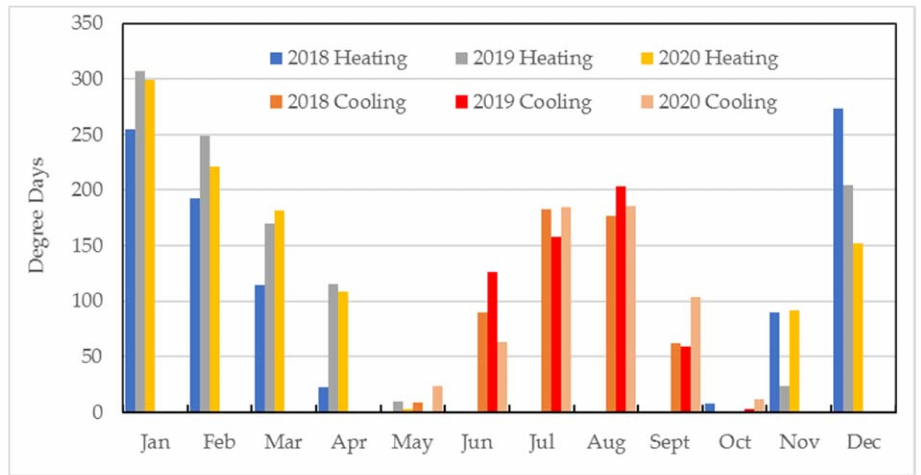
Figure 2. Heating (HDD) and cooling (CDD) degree days for the Greater Athens region for 2018, 2019, and